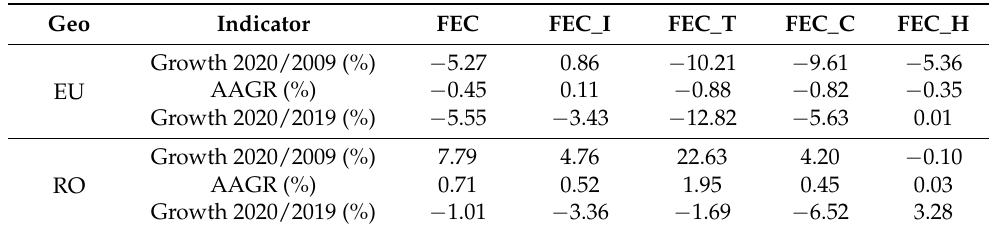
Table 3. Analysis of the evolution of the final energy consumption in use and the final energy consumption by sectors from 2009 to 2020.